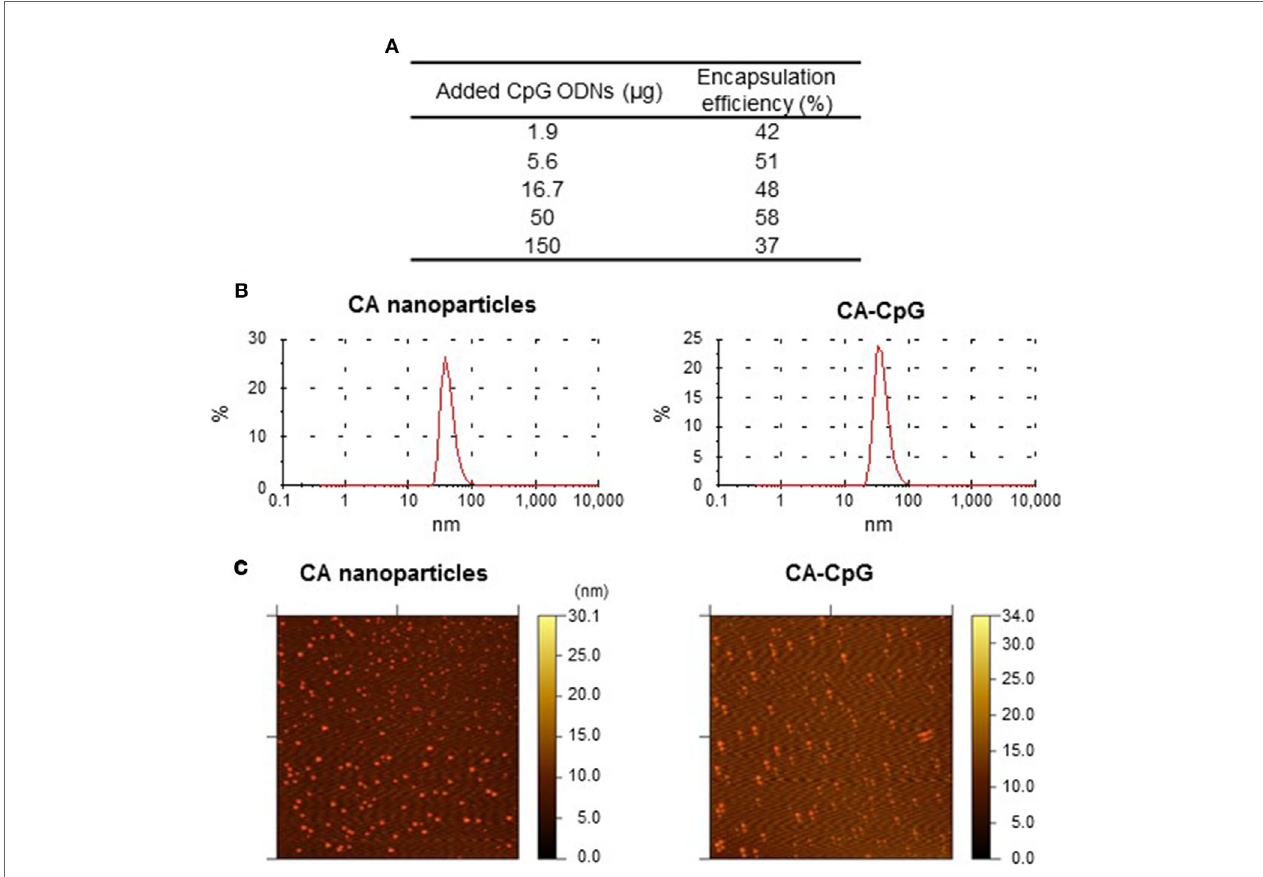
FigUre 1 | Encapsulation efficiency and size distribution of carbonate apatite (CA)-cytosine-phosphate-guanine (CpG). (a) The use of various amounts of K-type CpG oligodeoxynucleotides (ODNs) to generate CA-CpG showed that encapsulation efficiency was highest at 50 µg CpG ODNs. (B,c) The size distribution of CA-CpG was determined by dynamic light scattering (B) and atomic force microscopy (c) . CA-CpG was roughly the same size as CA nanoparticles that did not contain K-type CpG